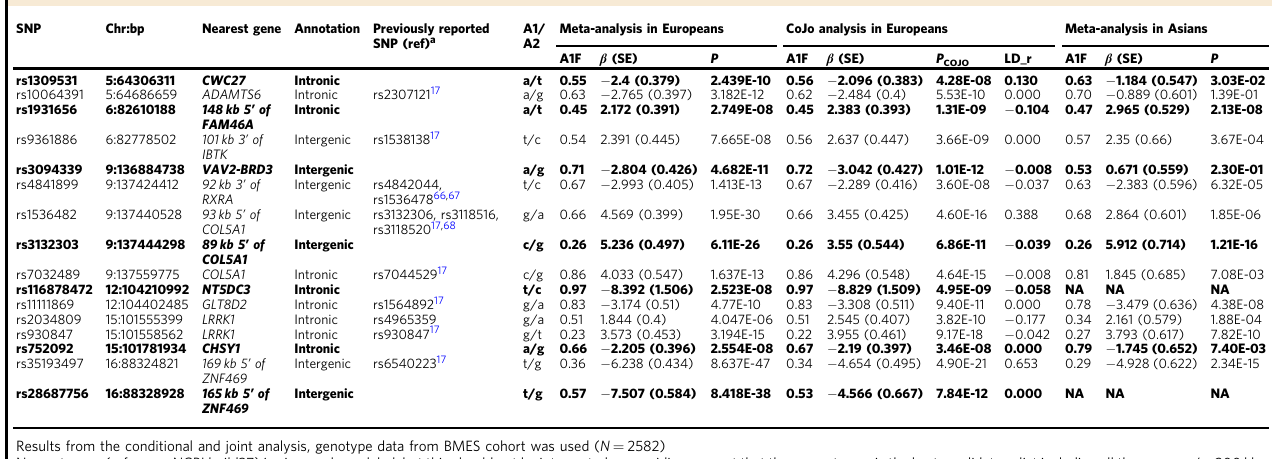
Table 3 CCT-associated variants from the conditional and joint analysis of the meta-analysis of European studies and replication in Asians